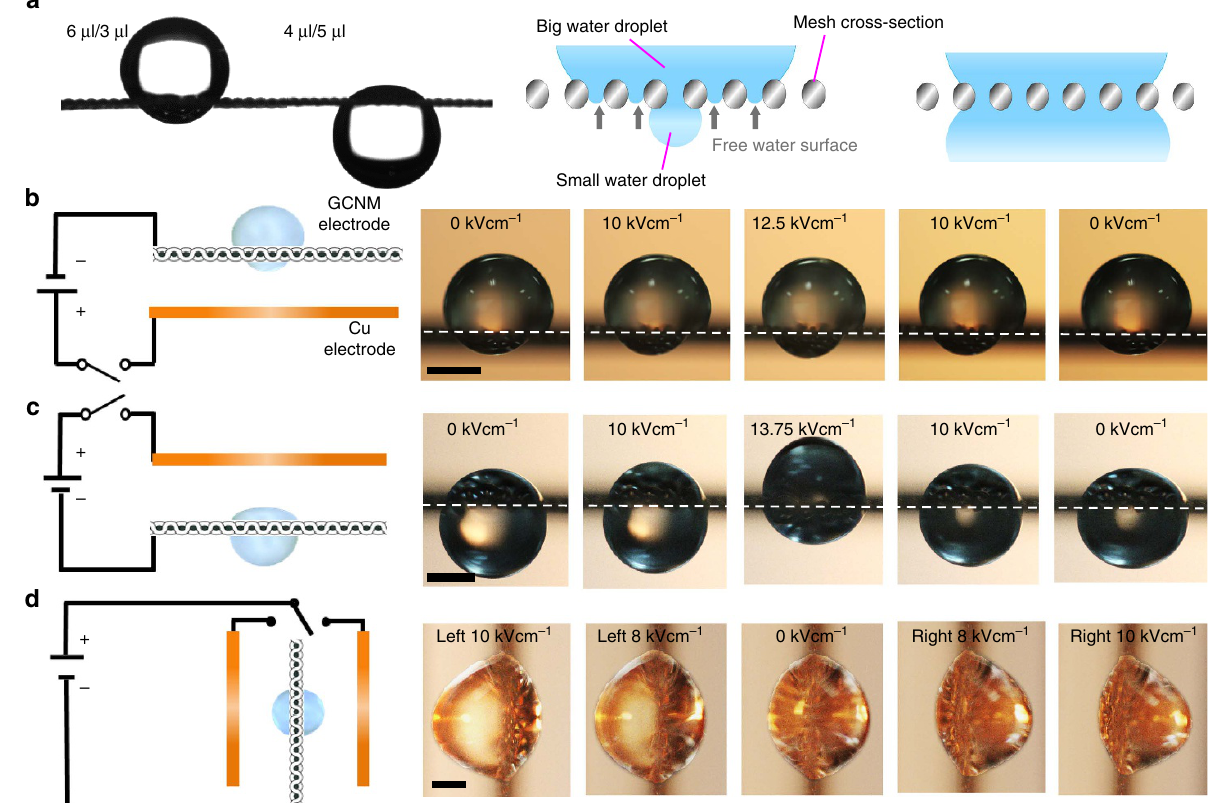
Figure 4 | Reversible actuation modes by electrowetting of graphene-coated Ni meshes. ( a ) Comparison of stationary droplet shapes when placing two differently sized droplets on both sides of the mesh and mechanism of penetration based on capillary forces in mesh openings. ( b – d ) Reversible actuation modes of two water droplets placed on both sides of the mesh with different electrode combinations. Scale bar,